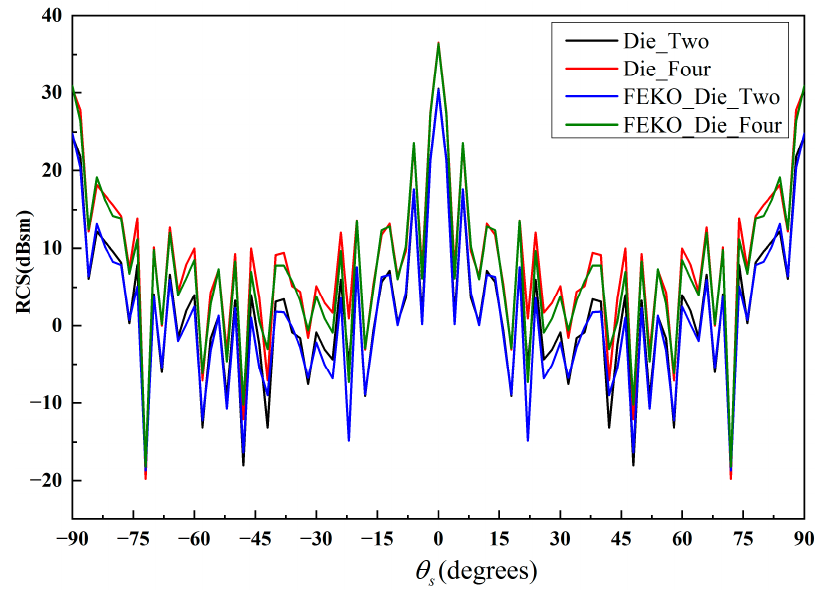
Figure 5. Mono-static RCS for HH polarization of dielectric cubes in free space.